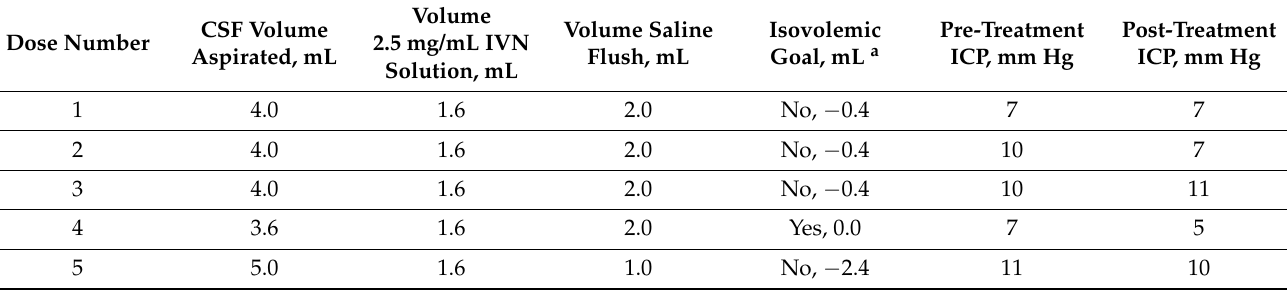
Table 3. Case 3: IVN Dosage and Related ICP